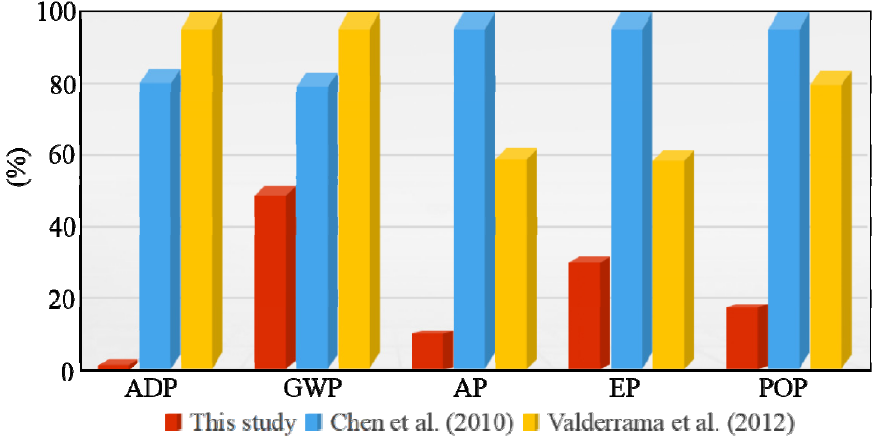
Figure 6. Comparison of LCA results for cement production studies